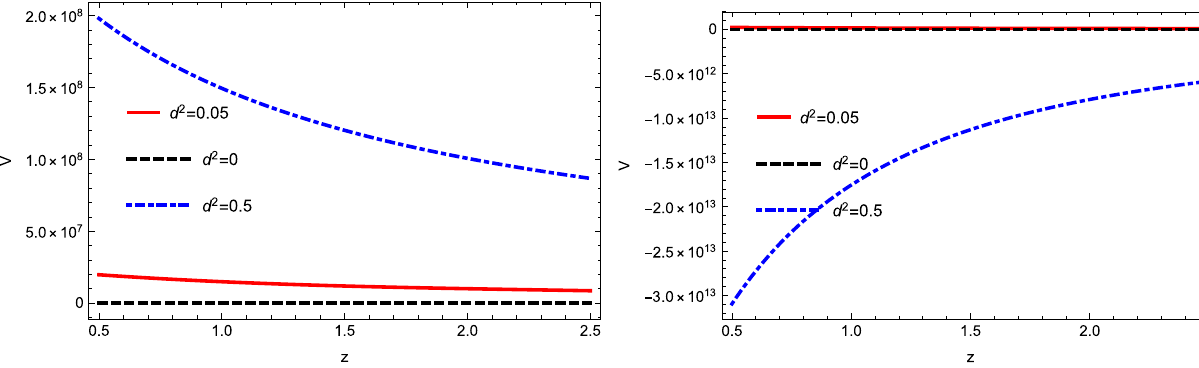
Fig. 23 Plot of V verses z for u = 1 and u = 2 . 002 for tachyon scalar field model